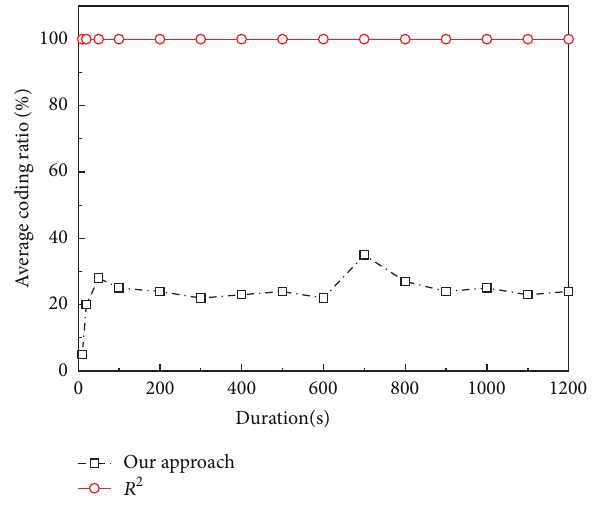
Figure 9: Average coding ratio versus simulation duration.